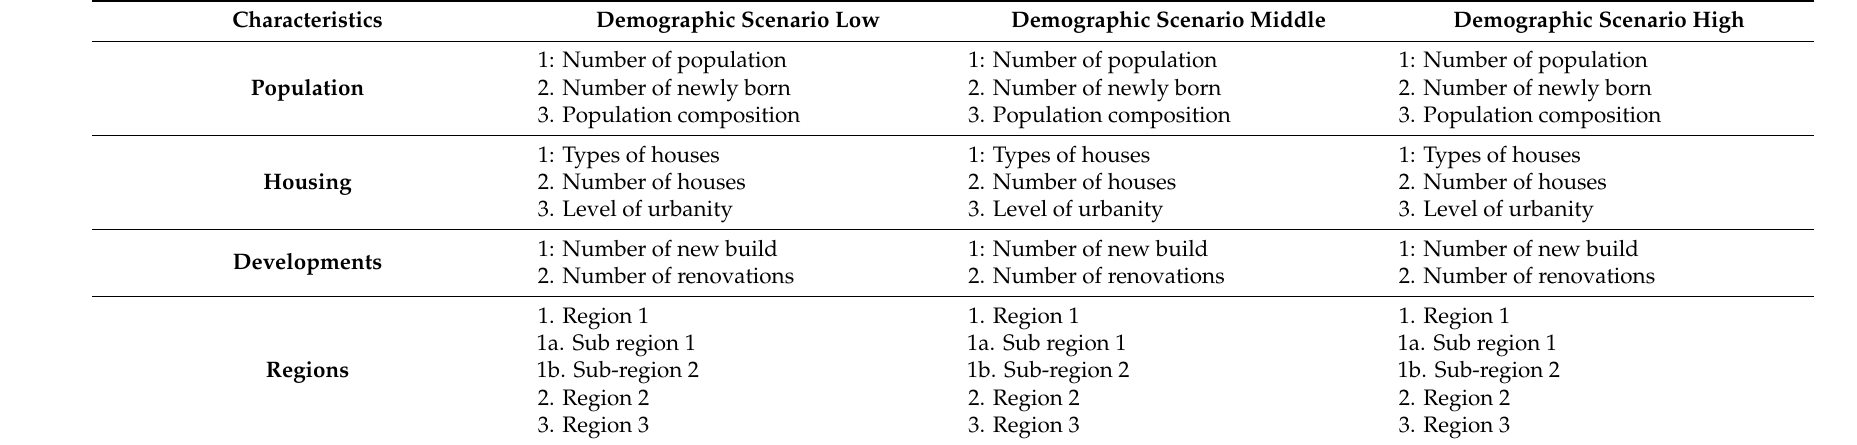
Table A2. Input data for the demographic scenarios of Limburg (STEP